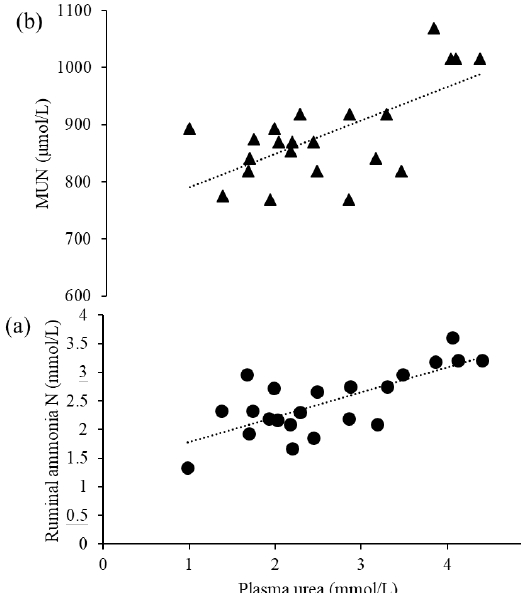
Figure 1. ( a ) Plasma urea nitrogen relative to ruminal ammonia N (ruminal ammonia N = 0.438 × plasma urea nitrogen + 1.3416; R ² = 0.53); ( b ) plasma urea nitrogen relative to milk urea nitrogen (MUN = 57.507 × plasma urea nitrogen + 734.86; R ² = 0.45).